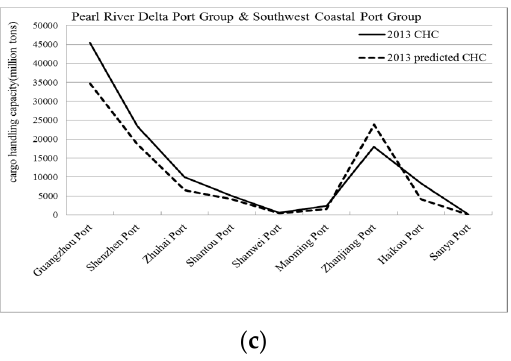
Figure 8. Fitting degrees at the port group level: ( a ) fitting degrees of the RBAPG; ( b ) fitting degrees of the YRDPG & SECPG; ( c ) fitting degrees of the PRDPG & SWCPG.